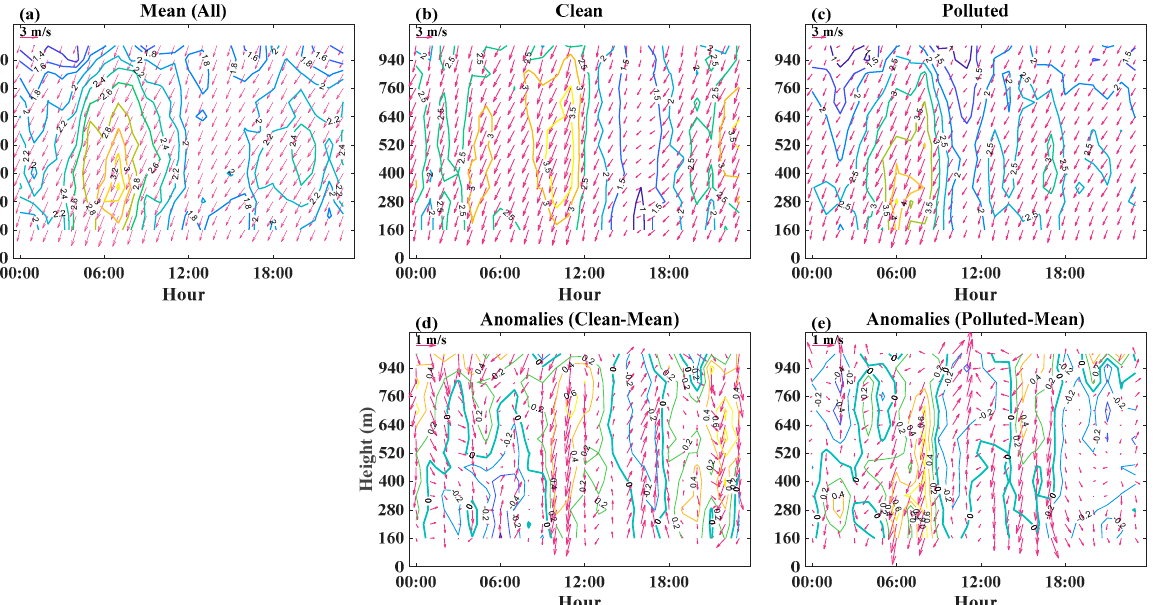
Figure 5. Diurnal variations of horizontal wind vectors (vectors) and wind speed (colored lines) under ( a ) climate mean, ( b ) clean, and ( c ) polluted conditions, and the anomalies (relative to climate mean) under ( d ) clean and ( e ) polluted conditions in JM for winters from 2016–2020.